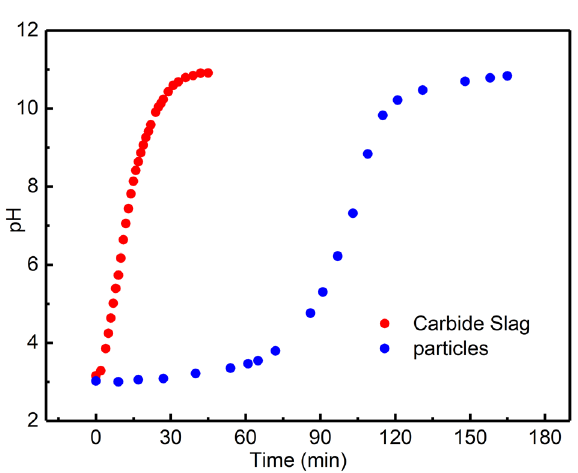
Figure 9. SEM images of composite particles at different calcination temperatures: ( a ) 25 °C, ( b ) 200 °C, ( c ) 500 °C, ( d ) 600 °C and ( e ) 800 °C.